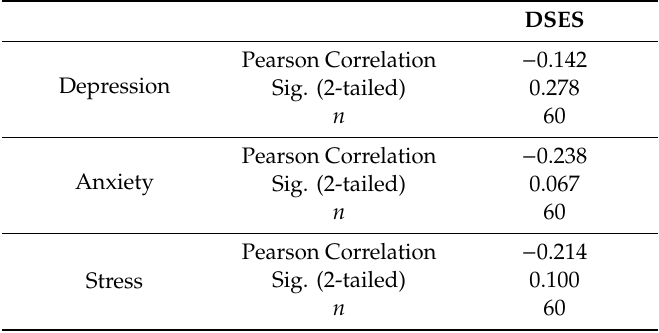
Table 5. Correlation of Depression, Anxiety, Stress with